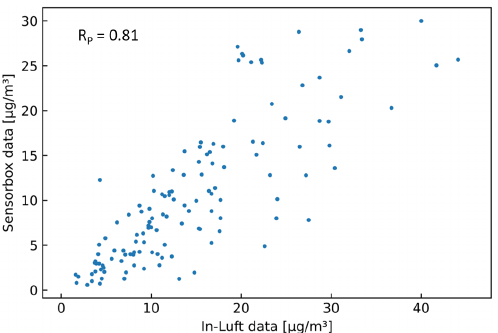
Figure 18. PM 10 hourly mean data recorded with mobile pilot sensor-box 6 located in Ebikon in the period from 15 October 2021 to 15 November 2021 compared to hourly mean data recorded at the in-luft station located in Ebikon, Sedel. Data recorded within a radius of 150 m around the maintenance depot Ebikon are removed. Number of mean hourly values: N = 129; Resulting correlations: R P = 0.81, R S =